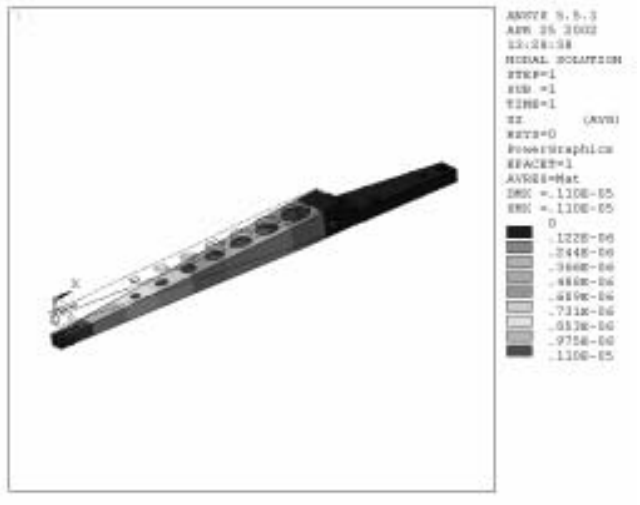
Fig. 17. Bond arm displacement under 1 N hitting force.